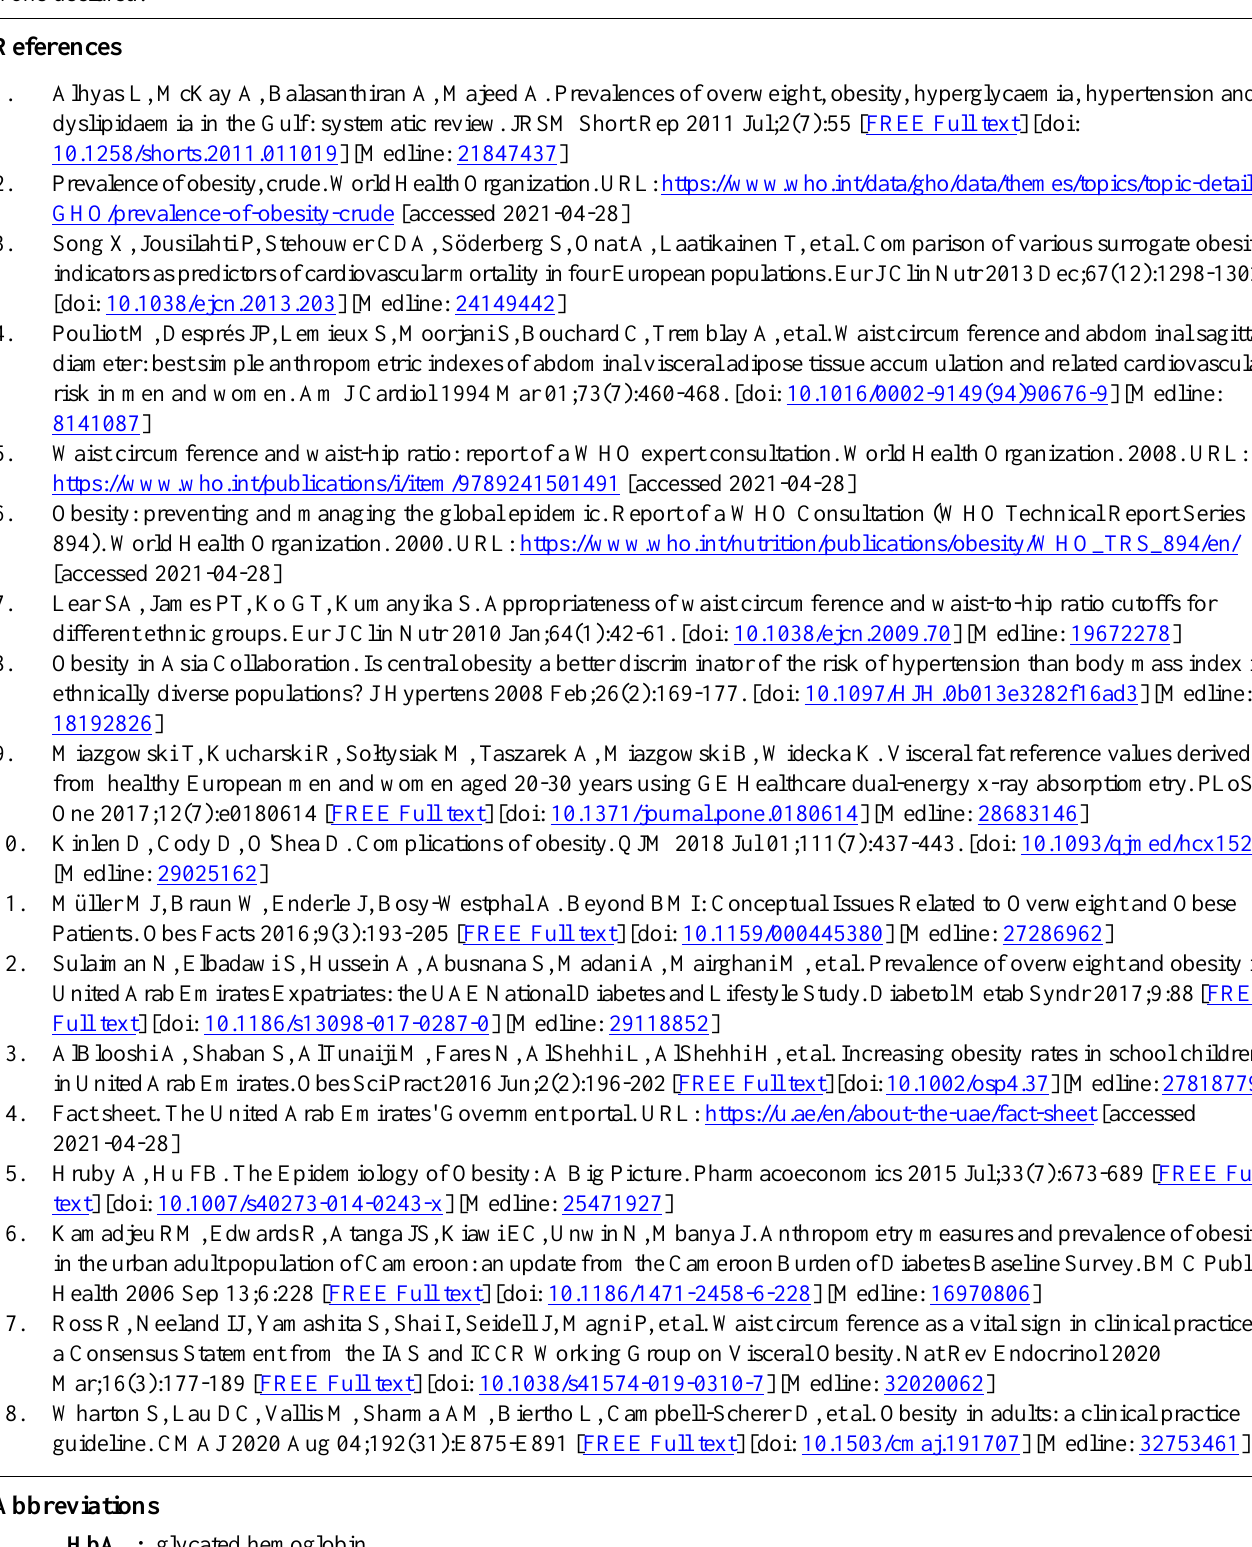
HbA : glycated 1c